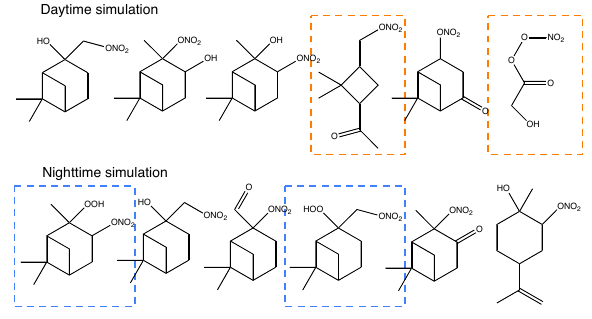
Fig. 8. Major organic nitrate oxidation products predicted by the MCM for daytime and nighttime simulations, initialized with ob- served monoterpene and oxidant concentrations at MFO. Struc- tures are shown in order of peak concentration, with highest on the left. Outlined structures show the more volatile daytime ni- trates (orange, predicted p vap > 10 − 3 Torr; C ∗ > 10 4 µgm 3 ) and less volatile nighttime nitrates (blue, predicted p vap ≈ 10 − 5 Torr; C ∗ ≈ 100µgm 3 ).